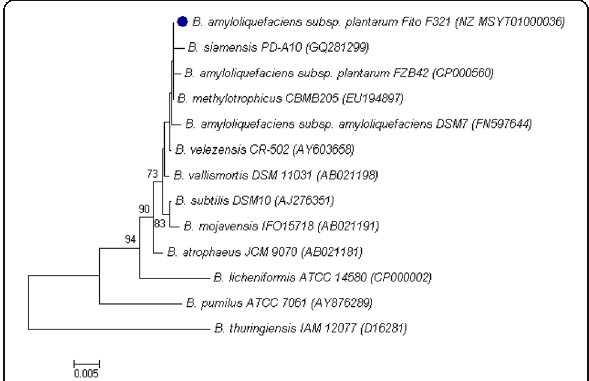
Fig. 2 Phylogenetic tree highlighting the taxonomic relation of